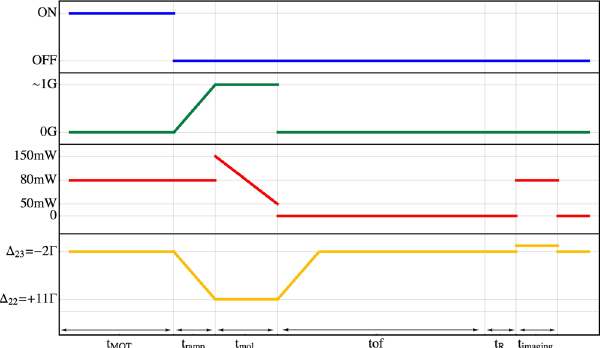
Figure 7. Experimental sequence. Time dependence of the quadrupole magnetic field (blue), the compensation magnetic field bias (green), the total optical power of the laser beams (red) and the cooler detuning (yellow). We load the MOT for t MOT , then we switch off abruptly the quadrupole magnetic field and ramp the laser frequency and the compensation fields to the molasses value in t ramp = 2 ms, and perform grey molasses for t mol . Then, we suddenly switch off the lights and let the atoms free to expand for t TOF before acquiring a fluorescence image of the atoms in F = 1. To do that, before the image we pump the atoms from the F = 1 to the F = 2 hyperfine state with a repumper pulse of t R = 200 μ s, and then switch on the cooler light at the same detuning as the MOT phase - we ramp the frequency back with a second 2 ms ramp when the lights are off during the free expansion - and acquire the